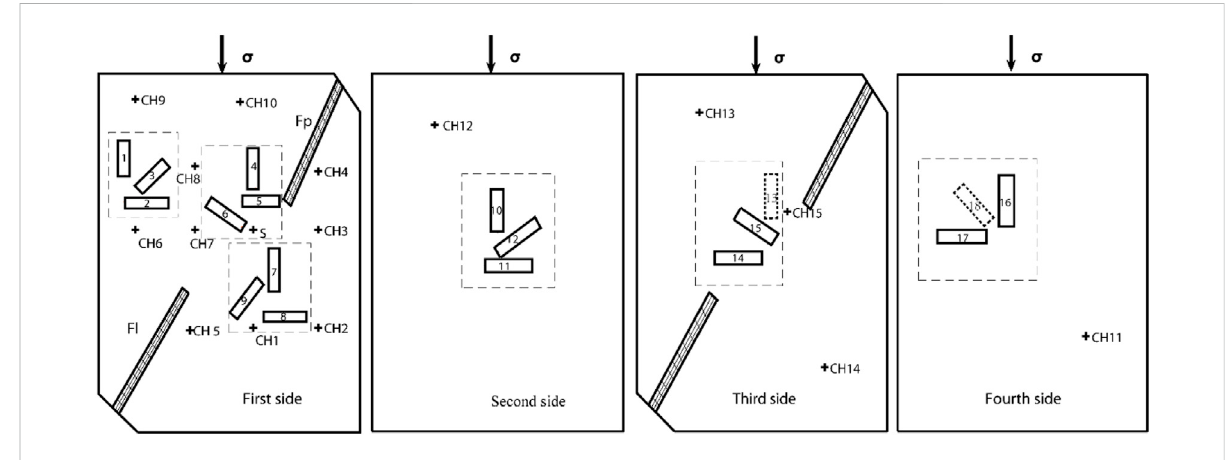
FIGURE 2 Sample model and observation system.